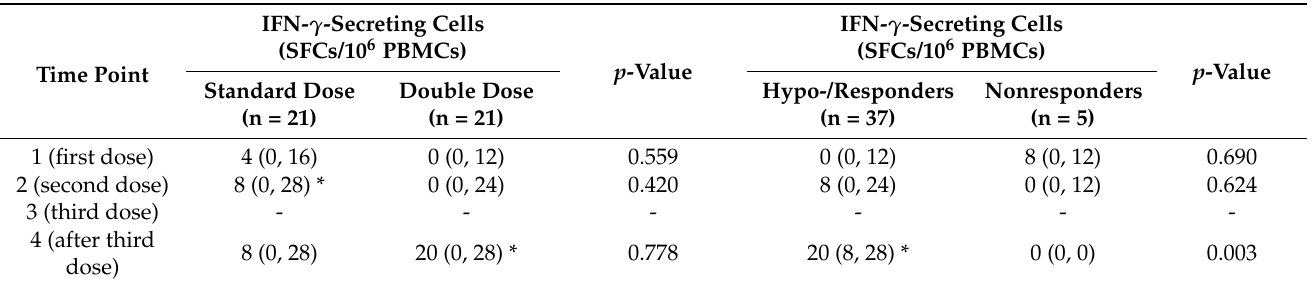
Table 3. Comparison of T-cell-specific response to hepatitis B antigen measured using IFN- γ ELSIPOT assay at three time